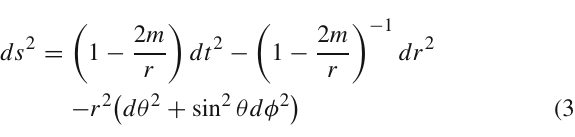
Fig. 6 M–R diagram for a = 0 . 001 and b = 0 . 04